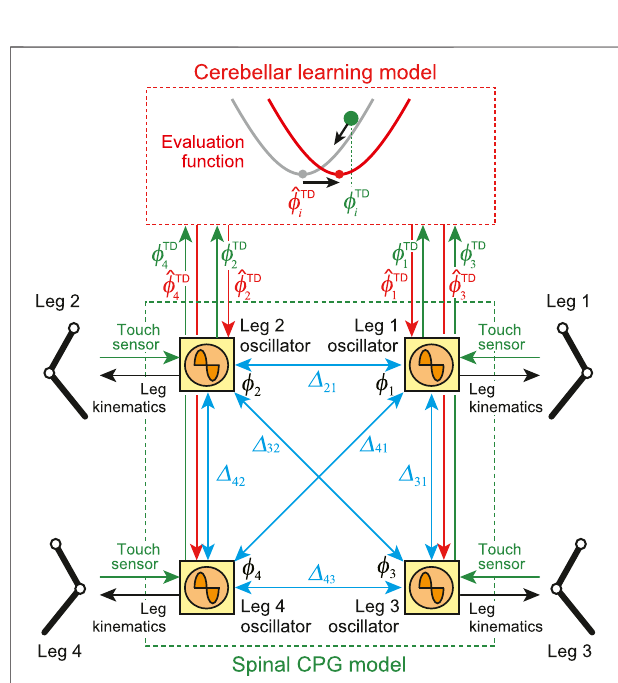
FIGURE 2 | Locomotion control model composed of spinal CPG and cerebellar learning models. Spinal model consists of four phase oscillators (Leg 1 – 4 oscillators). Blue arrows indicate relative phase Δ ij between oscillators.Oscillatorphasesaremodulatedbyphaseresettingbasedon touchsensorsignals(greenarrows)anddesired(predicted)touchdowntiming (red arrows). Oscillator phases determine leg kinematics (black arrows). Cerebellar model receives touchdown phase (green arrows) and modi fi es desired (predicted) touchdown phase using evaluation function, which is sent to spinal model (red